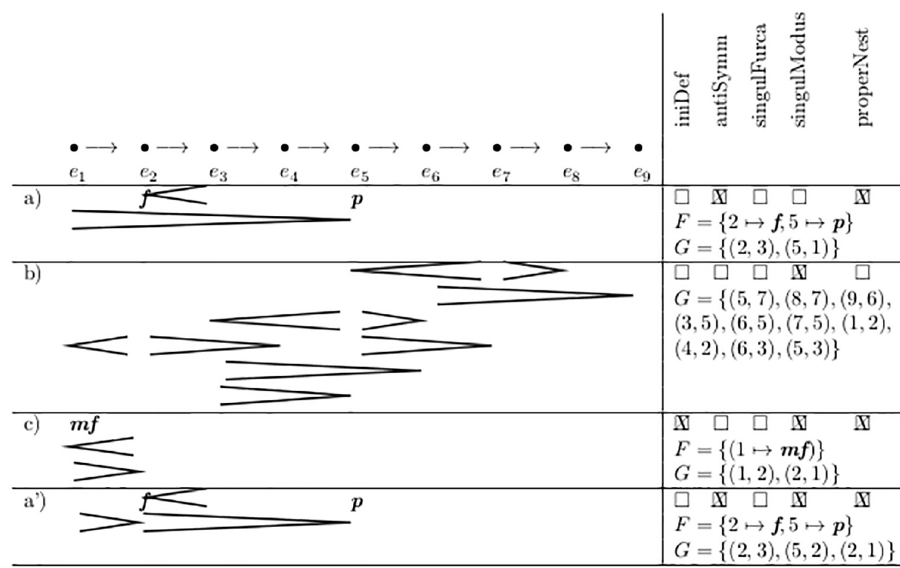
Fig 4. Syntactic structures of intensities and their